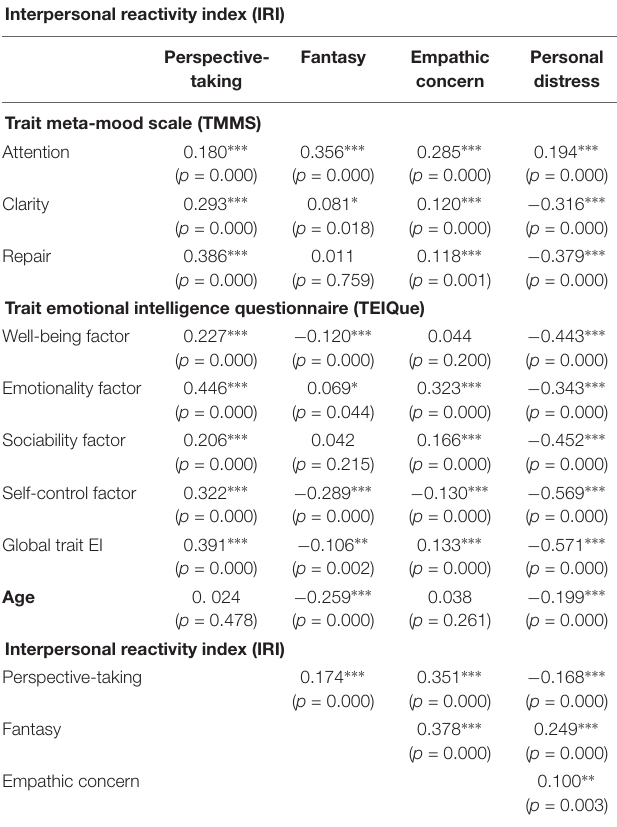
TABLE 2 | Pearson correlations between the emotional intelligence dimensions and the Interpersonal Reactivity Index. Interpersonal reactivity index